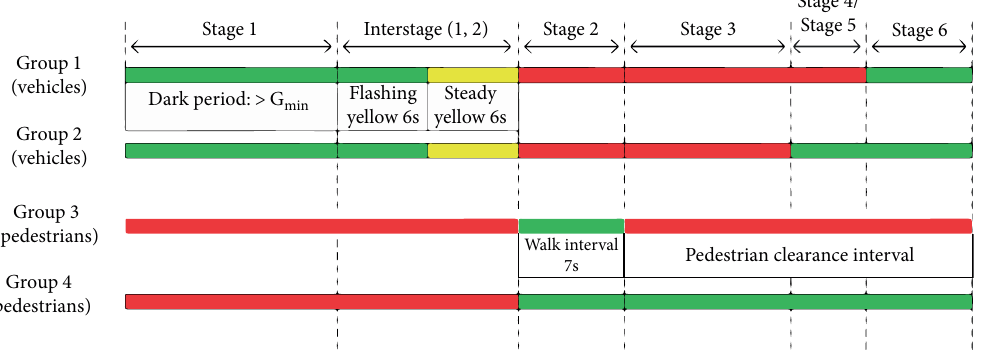
Figure 6: The signal group and stage division in simulation models for